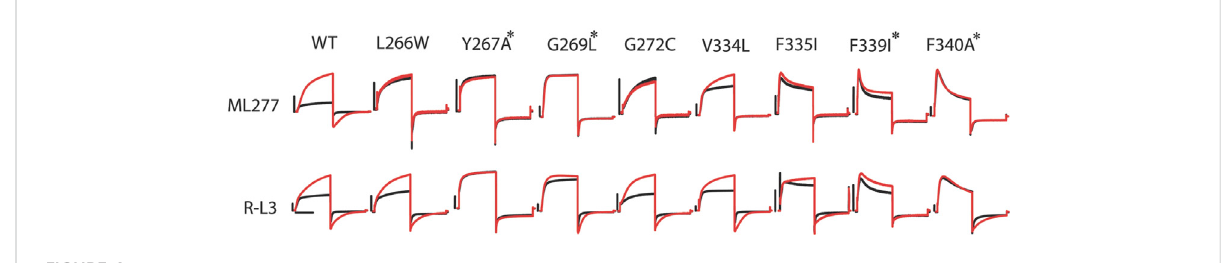
FIGURE 4 R-L3 shares somecommonresidueswith ML277 for functional effects. Representative recordings of mutantsof all eight residuesnecessary for ML277 effectbefore (black)andafter (red) ML277application(toppanel). Representativerecordingofthesamemutantsbefore (black)and after(red) R-L3 application (lower panel). Common residues that abolish the effects of both ML277 and R-L3 are marked with a star (*). The scale bar in the fi gure is a 0.5 s time